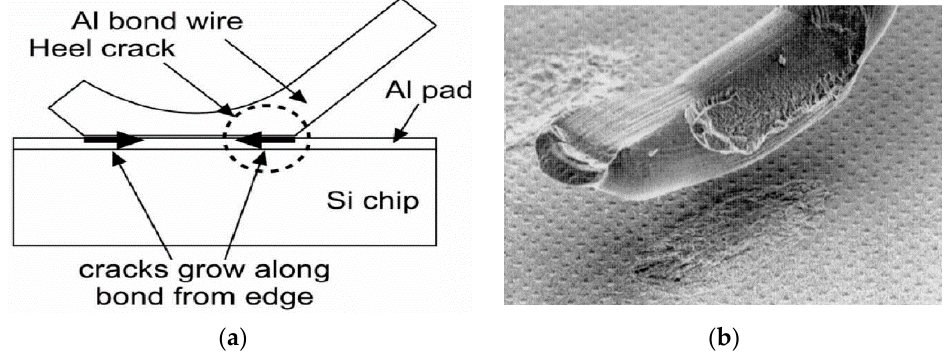
Figure 20. ( a ) Crack propagation direction in Al-bond wire lift-off and ( b ) Scanning electron microscope (SEM) image of bond wire lift-off [41].